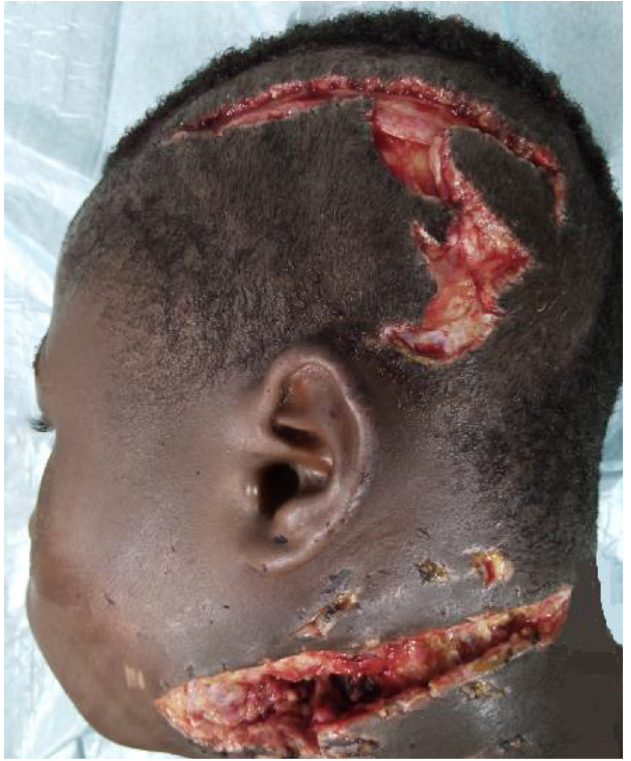
Fig. 4. Deep cervico-facial and tempo-parietal delamination.